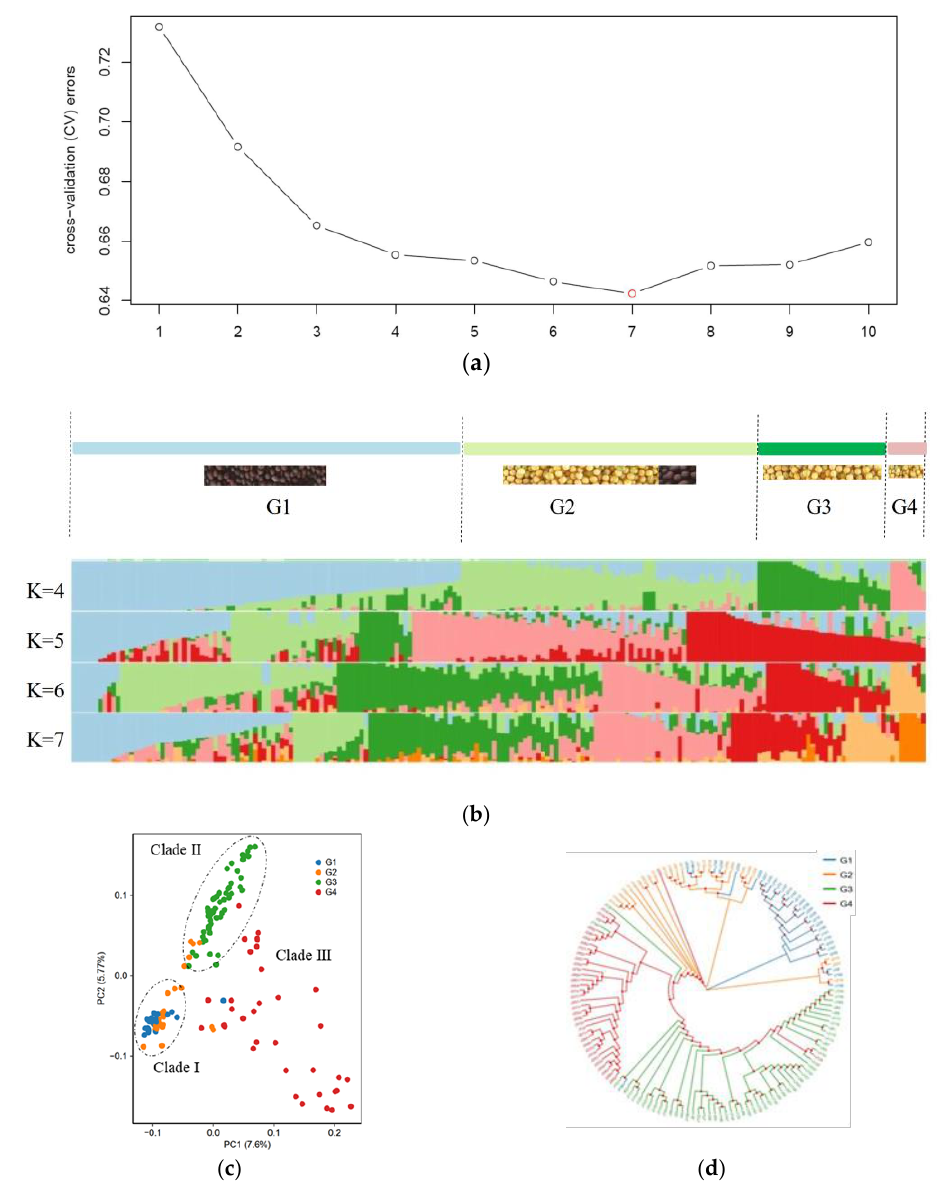
Figure 1. Genetic diversity and population structure of the studied B. juncea accessions. ( a ) ADMIX- TURE was used to analyze the population structure of accessions, and the cross-validation error was calculated when K was 1–10. ( b ) The population structure when K was 2–7. Each individual is represented by a line with different colors, and the group to which the individual belongs is inferred based on the proportion of the color. The seven color regions arranged from left to right in order to represent G1 to G4, respectively. ( c ) PCA of the group; one point represents an individual. Clades with bootstrap values of above 50% are indicated by a circled red dot. ( d ) Phylogenetic tree of the